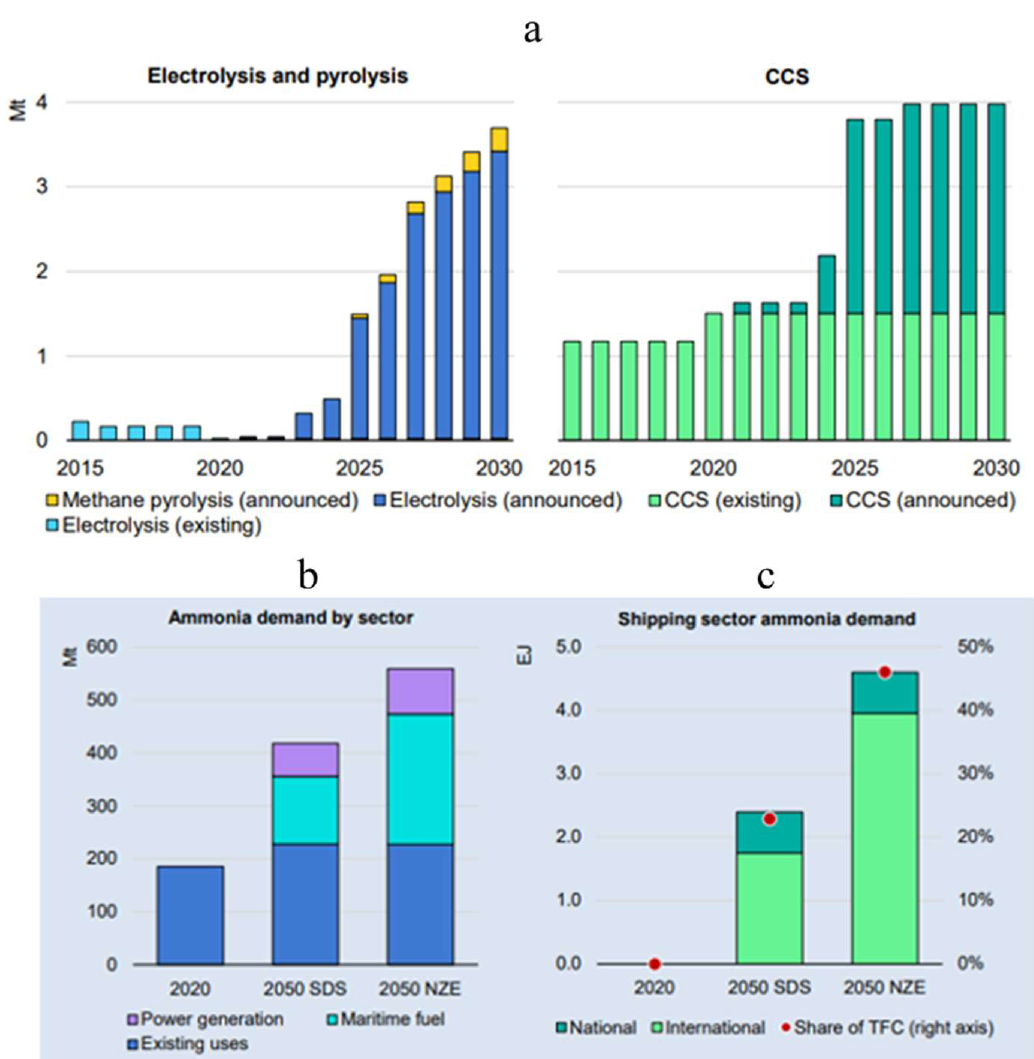
Figure 4. ( a ) Pathways to near zero emission ammonia production (current and announced); ( b ) ammonia demand by sector (SDS: sustainable development scenario; NZE: net zero emissions); ( c ) shipping sector ammonia demand [42] (Published under license CC BY 4.0).